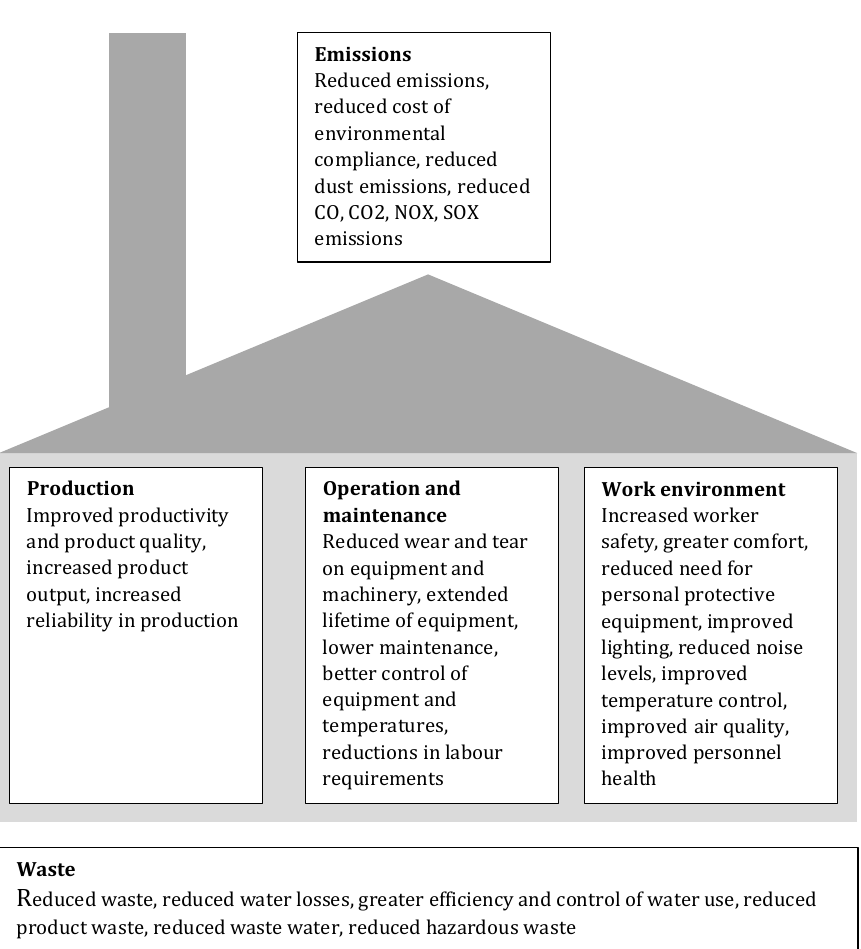
Figure 1. Examples of industrial non-energy benefits [20–22,25,27,33–36] categorised similarly to Finman and Laitner [25] and Worrell et al. [22].